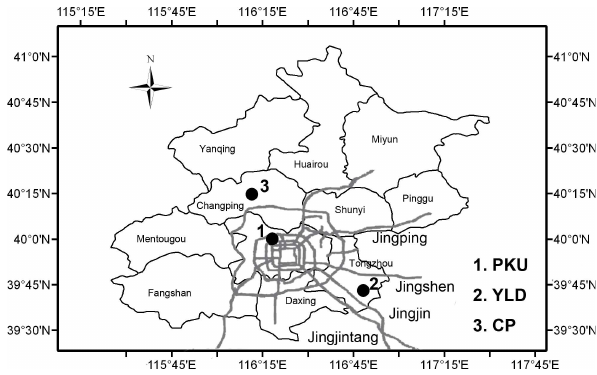
Fig. 1. Locations of the sampling sites used during the CareBeijing 2008 study: 1. PKU site, 2. YLD site, and 3. CP